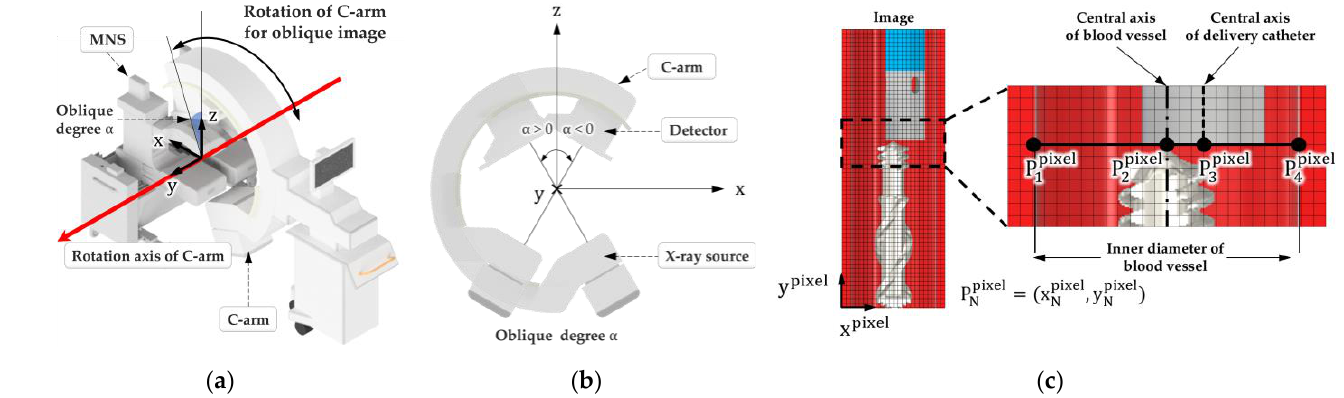
Figure 3. ( a ) Placement of the MNS and C-arm ( X -ray imaging device) and the rotational axis of the C-arm; ( b ) definition of the oblique angle; ( c ) representation of pixel coordinates in an image.